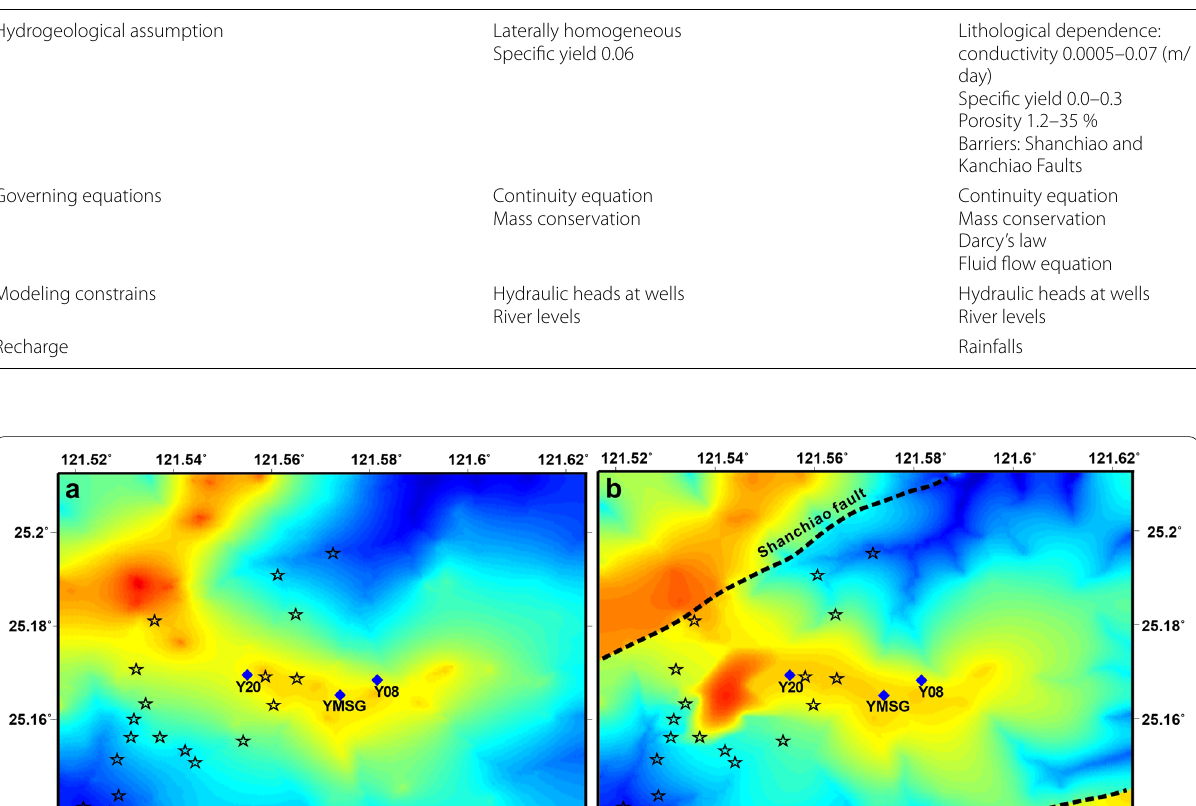
Table 3 A summary and comparison of Models A and B Model A